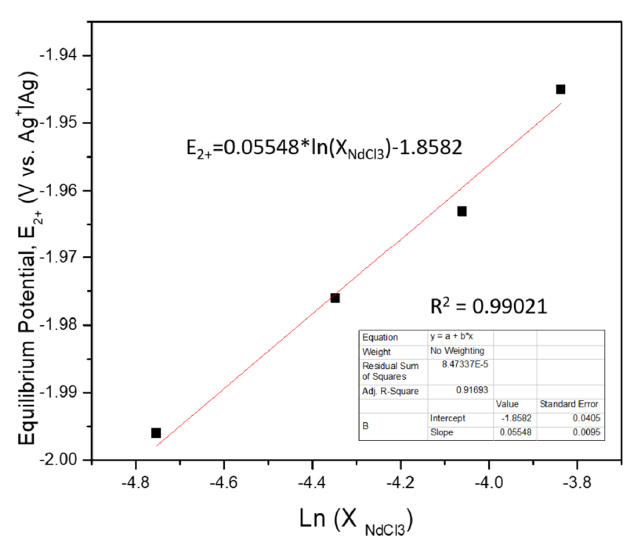
Figure 9. −1.86 V apparent standard potential vs. the 5 mol% Ag+ │ Ag reference scale at 773K. Figure 9. − 1.86 V apparent standard potential vs. the 5 mol% Ag +| Ag reference scale at 773